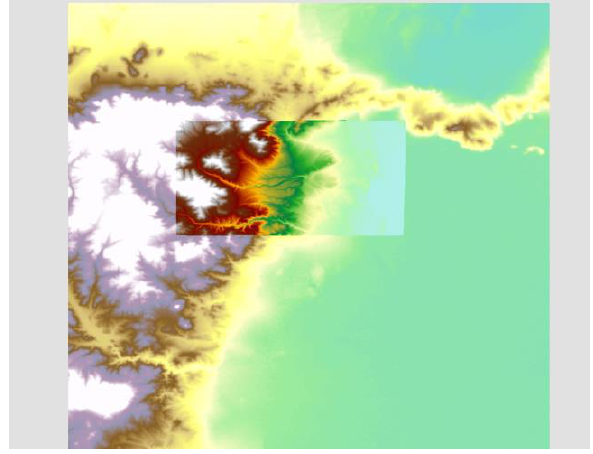
Figure 9. Overlap of DTED DEM and Sentinel-1A DEM After overlapping the data, totally 90 points are picked from different areas for compare to each other. That is the coordinate list of points and name of points means characteristic symbol in it. The “M” symbolized points mean mountain area, “A” means average (not too sloppy, not too plane) and last “P” symbolized points mean plate